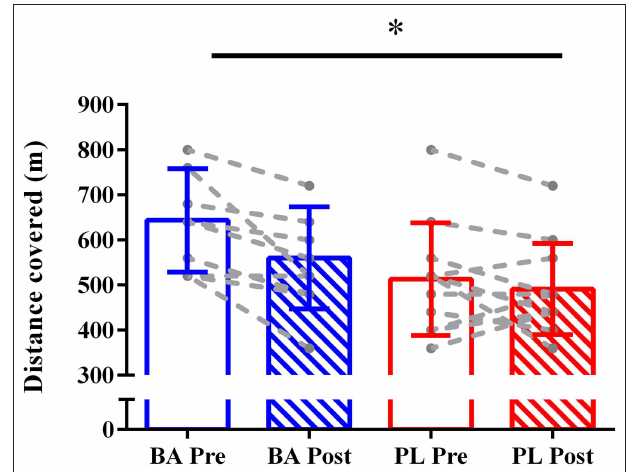
FIGURE 1 | Distance covered during the YoYo IR 1 test in the beta-alanine (BA) and placebo (PL) groups pre- and post-supplementation. * P = 0.004. Effect of